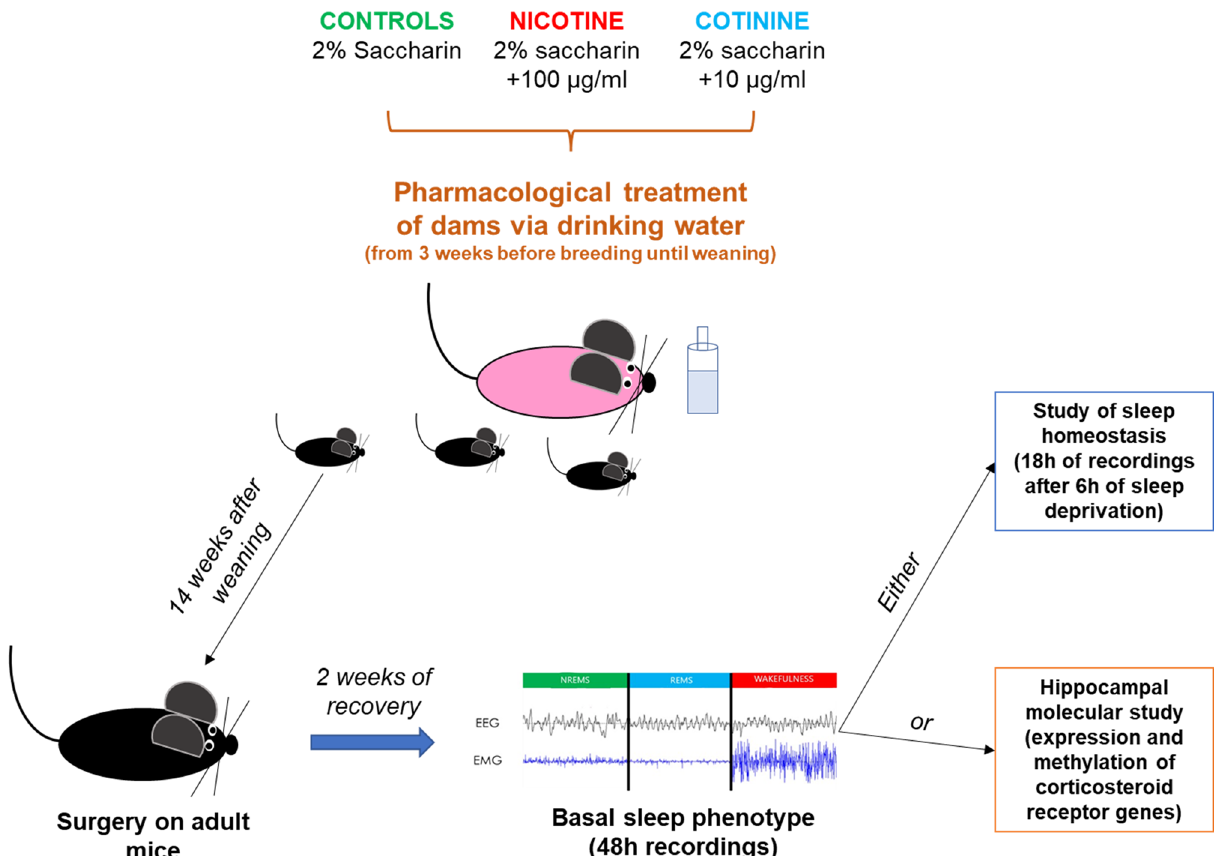
Figure 1. Graphical representation of experimental design. The picture shows the scheme of the experimental protocol used in this study (cf. Methods). C57Bl/6 J dams (3–4/cage) drank water laced with 2% saccharin, or 2% saccharin + 100 µg/mL nicotine freebase or 2% saccharin + 10 µg/mL cotinine for 3 weeks prior to and 6 weeks after mating. Pups never drank these solutions. Adult (≈ 17 weeks old) male mice underwent surgery to implant electrodes for electroencephalographic (EEG) and electromyographic (EMG) signals. After at least 2 weeks of recovery, basal sleep phenotype was assessed by recording EEG/EMG signals for 48 h. After that, mice were split in 2 subgroups to evaluate either the sleep homeostasis (after 6 h of sleep deprivation) or the hippocampal expression and methylation of corticosteroid receptor records about the exact number of litters or of mice per litter included in the study, however, we did not need to manually equalize the litter size since litters were comparable between experimental groups in terms of number of pups and weight at birth 7 .